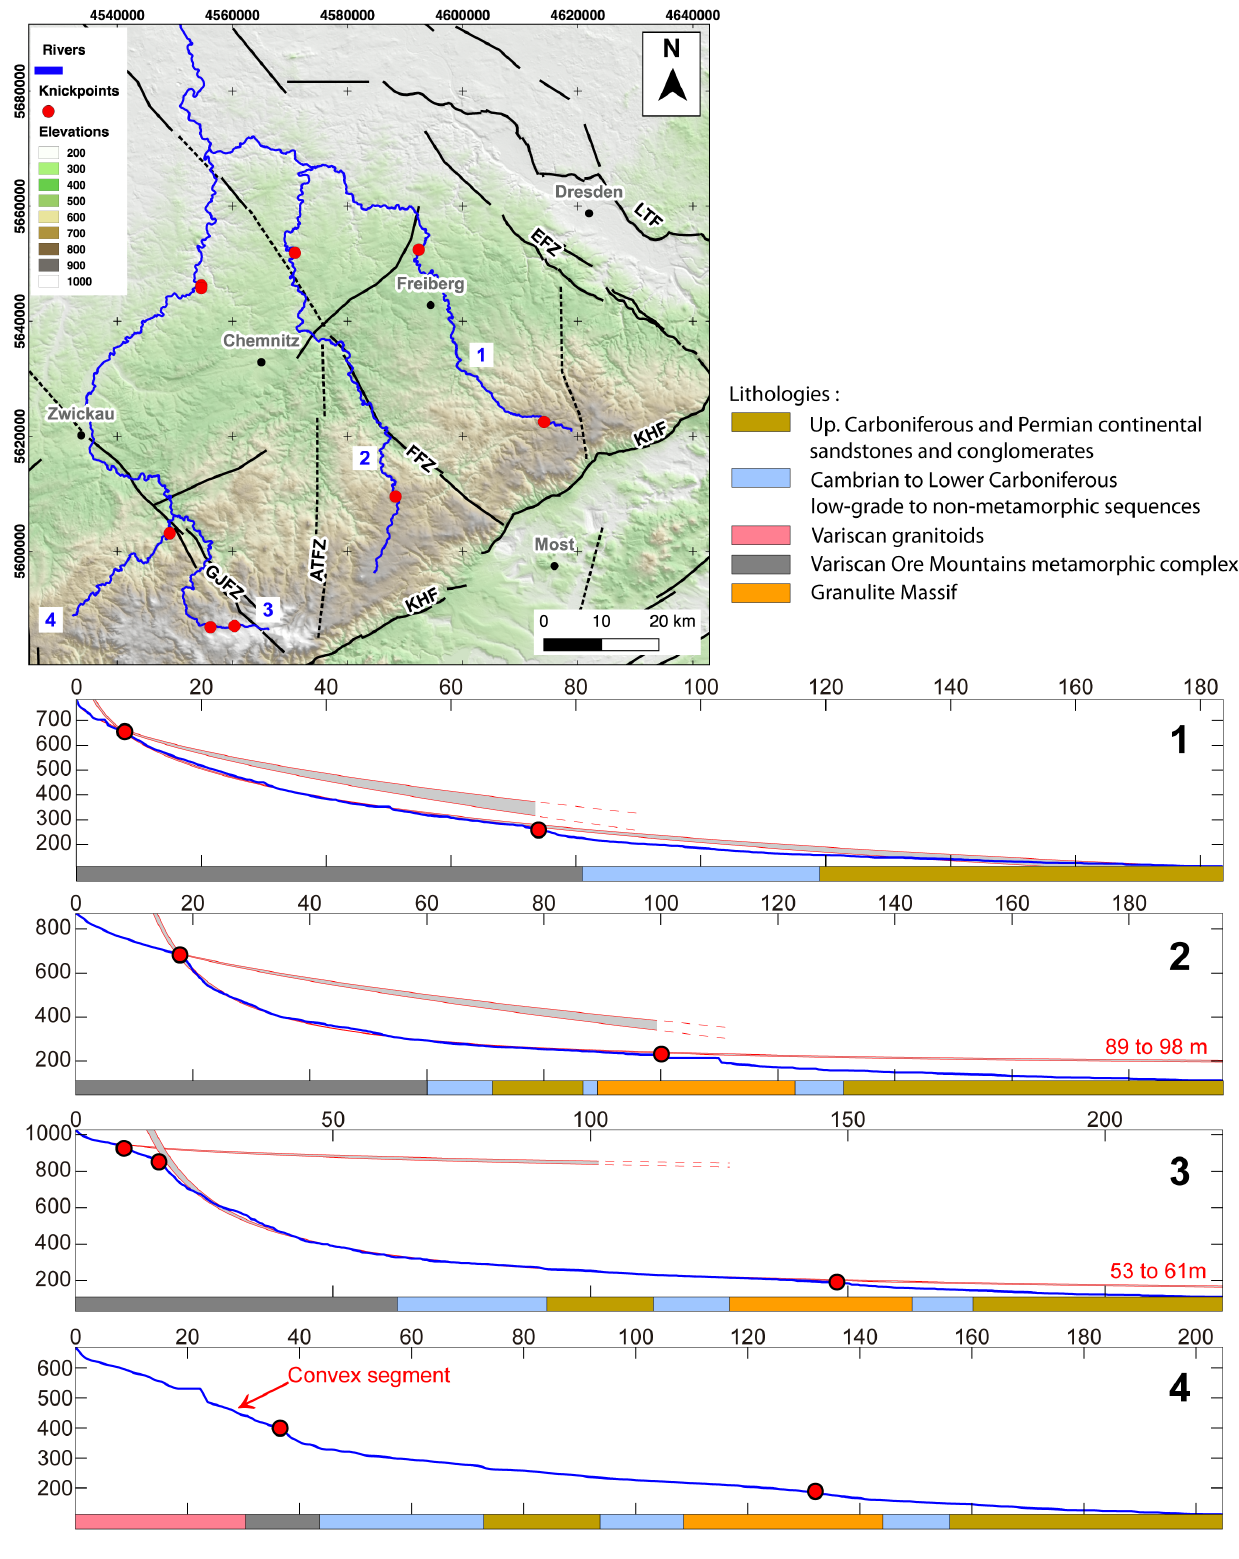
Figure 12. Examples of longitudinal river profiles from the Ore Mountains (extracted from 20-m resolution DEM). Red points indicate the main knickpoints. Red lines and grey shades show reconstructed profiles using segments located above knickpoints (the method is explained in Figure 6C). Distances are in kilometers, and elevations are in